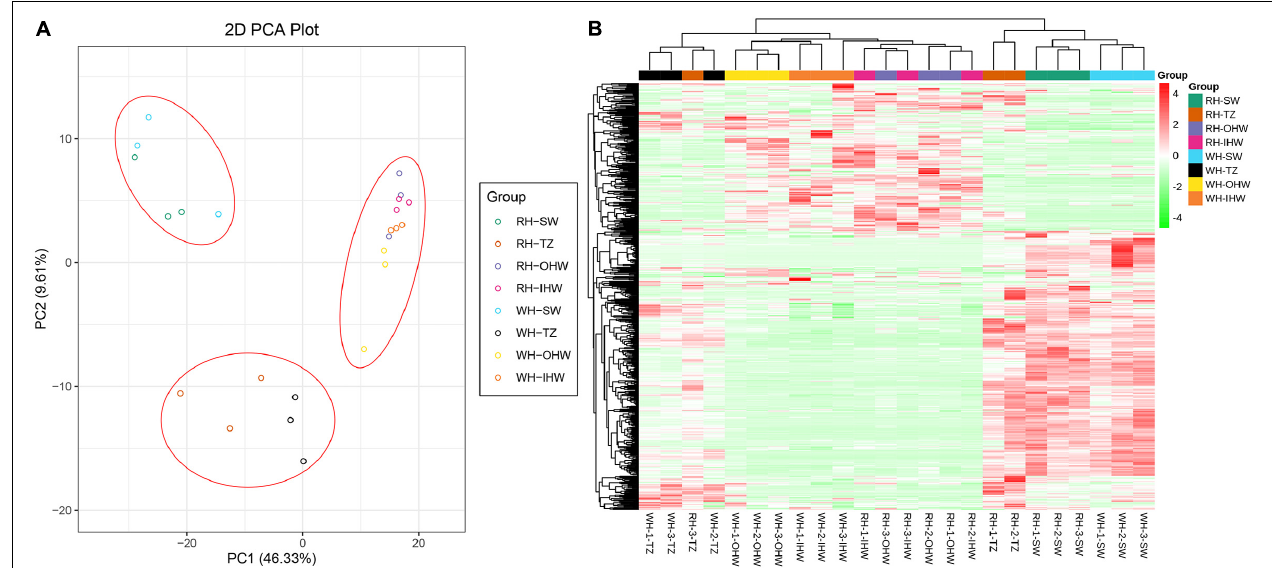
FIGURE 2 | (A) PCA score plot of the metabolites among SW, TZ, OHW, and IHW of red-heart and white-heart Chinese fir. (B) Heatmap of secondary metabolites among SW, TZ, OHW, and IHW in white-heart and red-heart Chinese